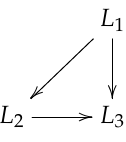
Figure 1. Topology of coodinated